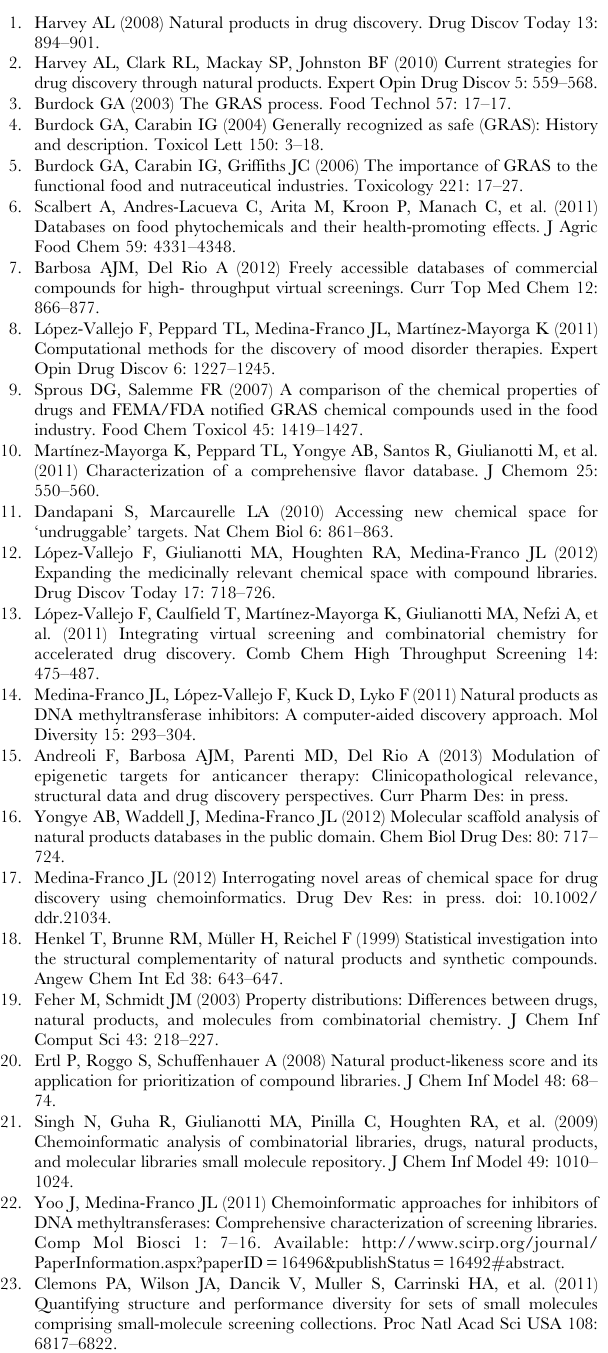
Table S1 Loadings for the first three principal components of the property space of five databases. Table S2 Counts of fraction of